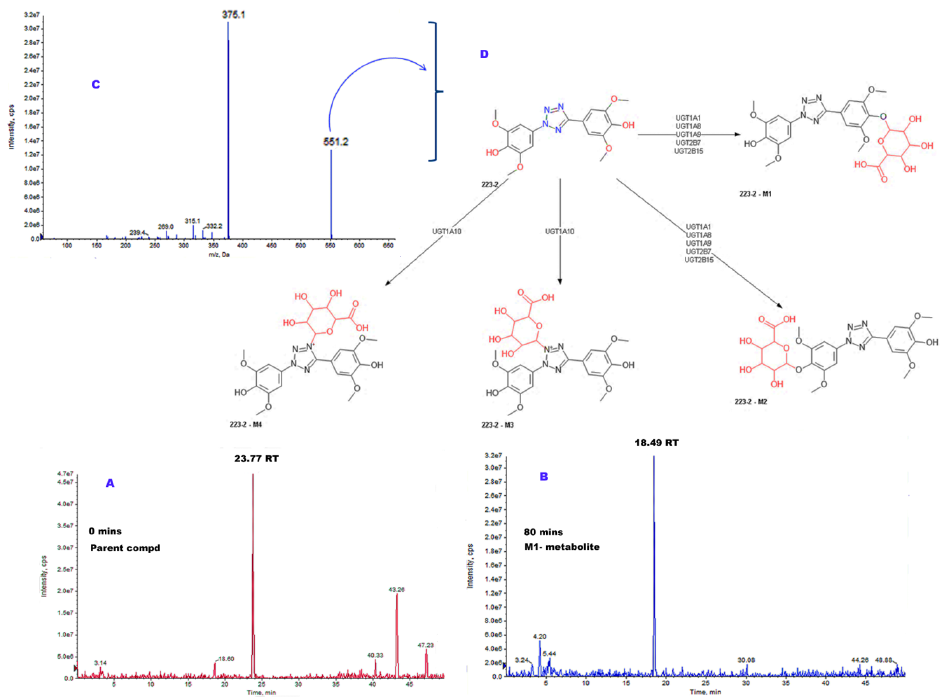
Figure 10. MetID studies of 223-2 incubated in hepatocytes until 80 min. ( A ) Representative chro- matogram at 0 min of incubated TbB ligand 223-2 at room temperature. The peak of the parent compound (223-2) is observed at RT of 23.77 min. ( B ) Representative chromatogram of incubated TbB ligand 223-2 at room temperature highlighting the formation of M1 metabolite at RT of 18.49 min due to metabolism of 223-2 ligand at 80 min. ( C ) Enhanced product ion (EPI) spectrum with the full range of M1 metabolite. Based on the fragmentation pattern, the parent ion m/z for this metabolite was found to be 551 (375 + 176). This m/z indicates the formation of glucuronide. ( D ) A schematic representation of the proposed O- and N-glucuronidation of 223-2 ligand, as the exact position of glucuronide binding to compound 223-2 could not be deduced from the fragmentation